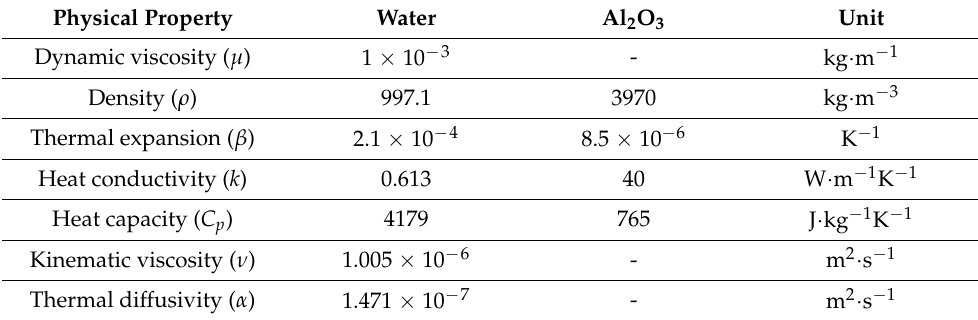
Figure 5. Contours of temperature at Re = 500, Ra = 10 5 for Al 2 O 3 -water nanofluid: ( a ) Cong et al. [6] and ( b ) result from the current model with the same configuration of Cong et al. [6]. 4. Results and Analysis 4.1. Effects of Reynolds Number After running simulations for each fin with varying Reynolds and Rayleigh numbers, the results were collated so the effects could be compared. Figure 6a shows the variation in the average Nusselt number for the rectangular fin (C0 fin) as these parameters change, and it can be seen that increasing either the Reynolds or Rayleigh numbers results in an increased average Nusselt number, showing greater convective heat transfer under these conditions. The graph also clearly shows that for smaller values of Rayleigh number ( ≤ 10 4 ) there is little difference in average Nusselt number between orders of magnitude however as the Rayleigh number increases it begins to dominate the flow at Reynolds numbers below 500. This is indicative of the natural convection requiring a minimum threshold before it begins to meaningfully contribute to the heat dispersion. Moreover, as the Reyn- olds number increases it can be seen that the average Nusselt numbers calculated for each value of the Rayleigh number get closer together, illustrating how the flows become less and less buoyancy-driven, as the forced convection begins to dominate. It may also be noted that for lower Rayleigh numbers there appears to be a linear relationship between the Reynolds number and the average Nusselt number however this relationship becomes more quadratic as the Rayleigh number increases.